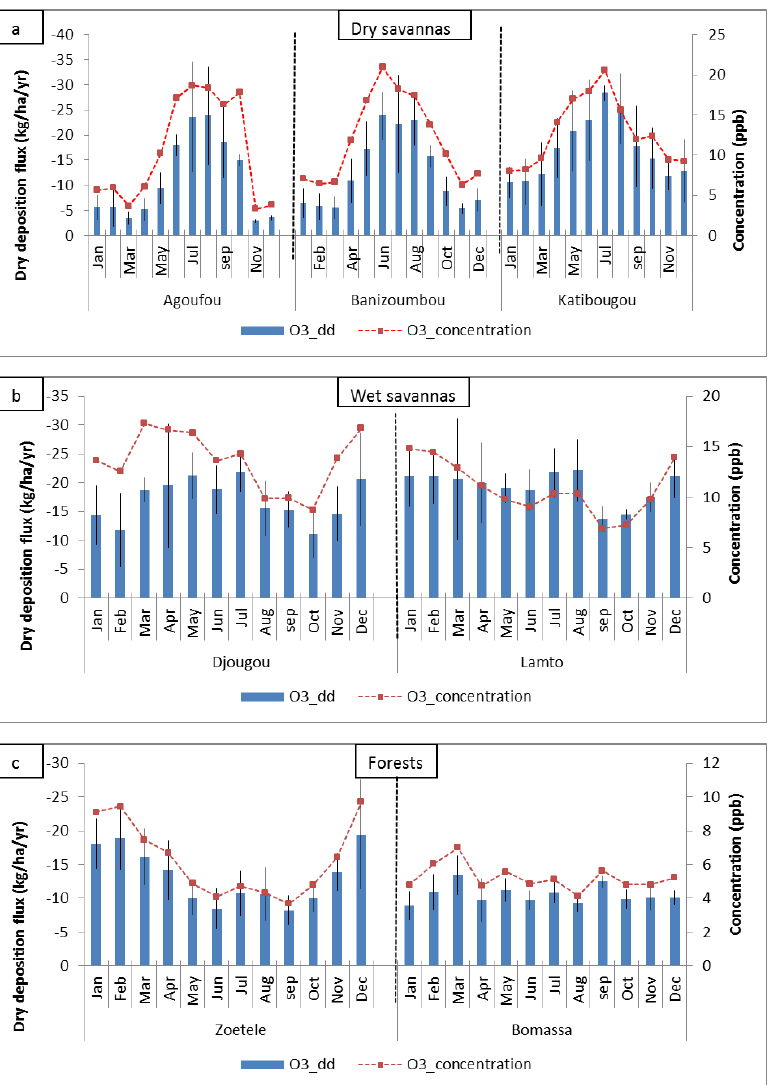
Fig. 9. Evolution of monthly dry deposition fluxes of O 3 (O 3 _dd) in kgha − 1 yr − 1 (2001–2007) on the transect dry savannas (a) , wet savannas (b) and forests (c) associated with evolution of O 3 concentrations